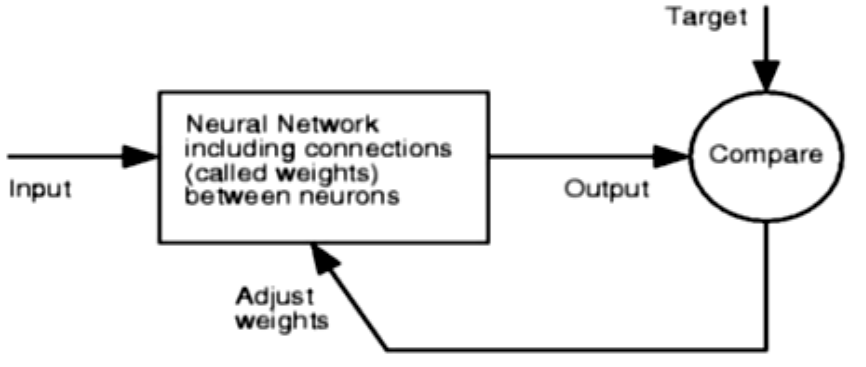
Fig. 1. Neural network block